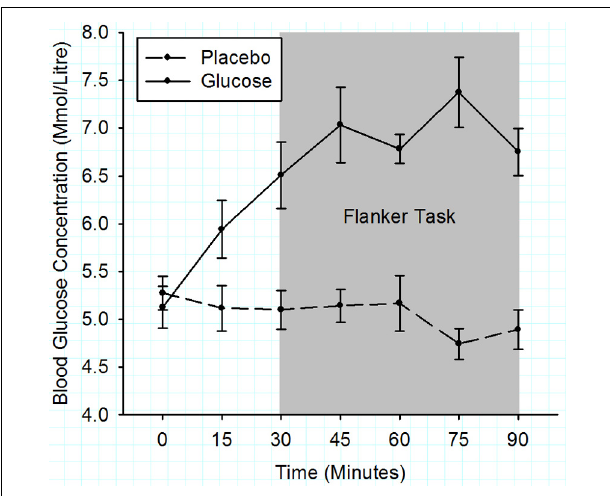
FIGURE 2 | Mean blood glucose concentrations measured in 15 min intervals for the duration of experiment 1. Solid lines represent the BGC in the glucose condition and dashed lines the BGC in the placebo condition. The gray shaded area indicates the time period when the flanker task was performed. Error bars represent the standard error of the